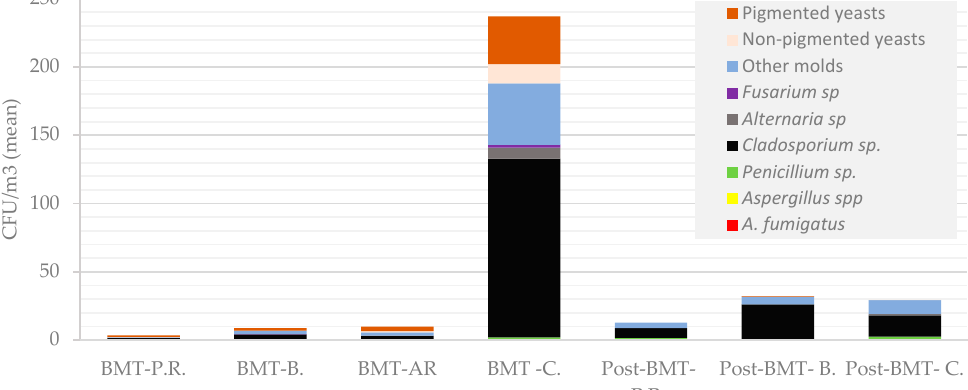
Figure 3. Concentrations of particular fungal species/morphotypes (CFU/m 3 ) in the air of different rooms of BMT and post-BMT wards. The following abbreviations were used: P.R.—patient rooms, AR—anteroom, B.—bathrooms, C.—corridors. Table 2. Concentrations of fungi in the air of the hospital for lung diseases.